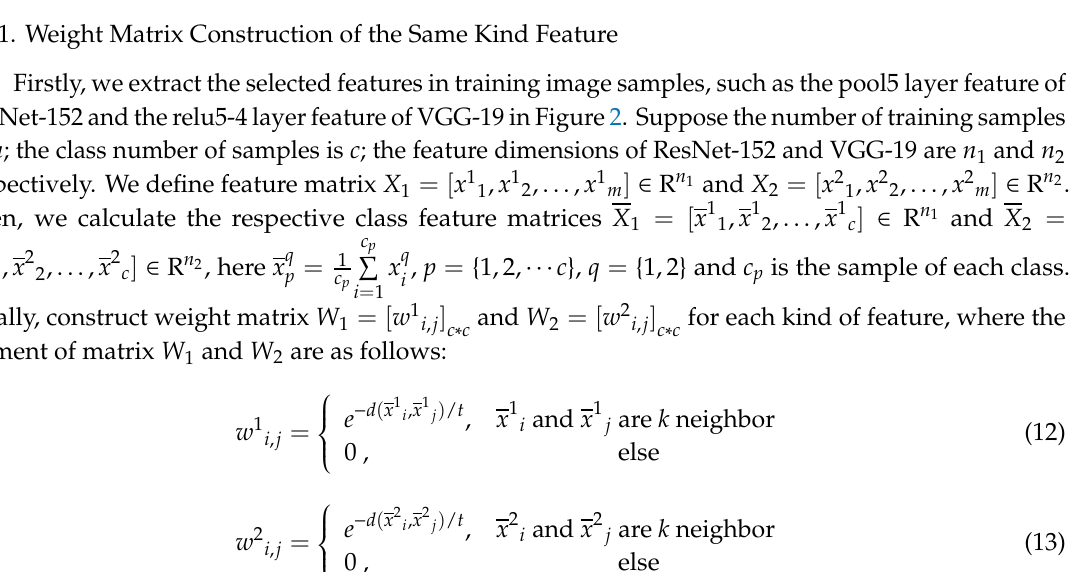
Figure 3. Internal structure fusion of multi-feature.